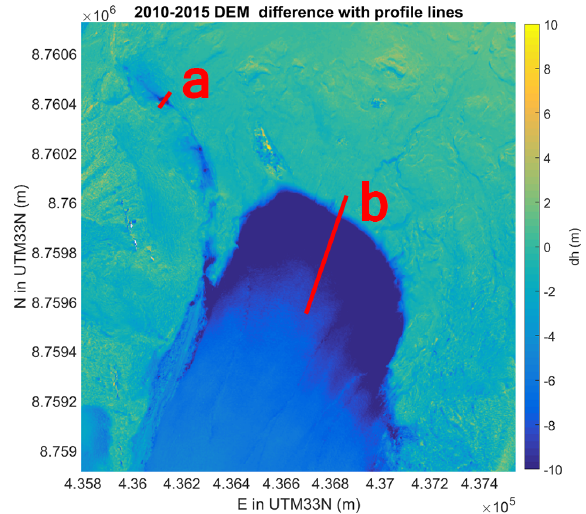
Figure 11. DEM difference map of the tongue of the glacier be- tween 2010 and 2015. In red are the two lines from which profiles were extracted: “a” for the ice-cored moraine and “b” for the glacier